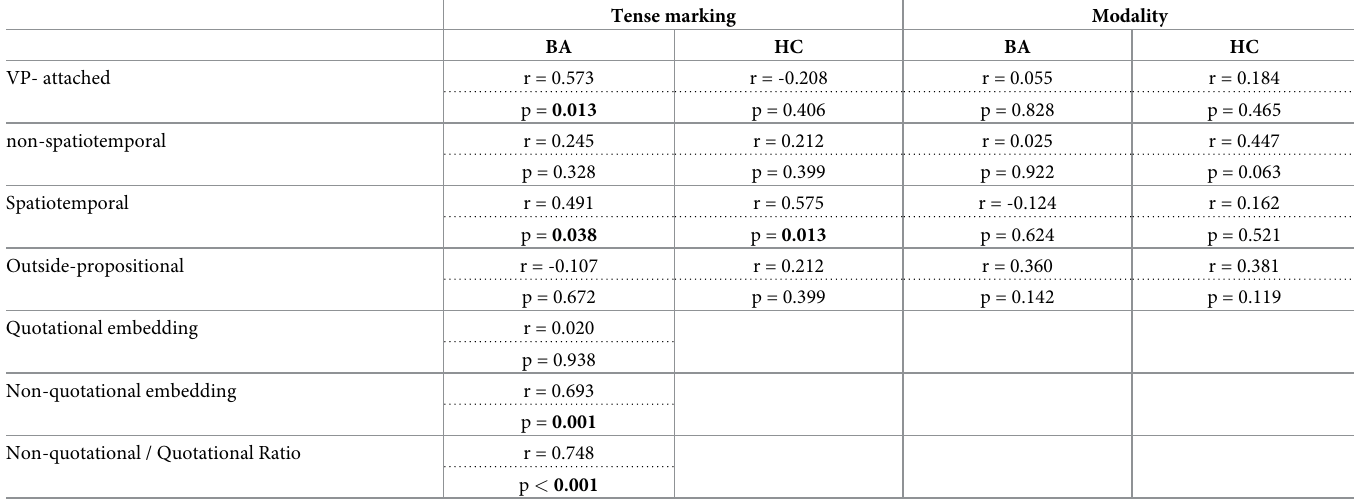
Table 6. The results of the correlational